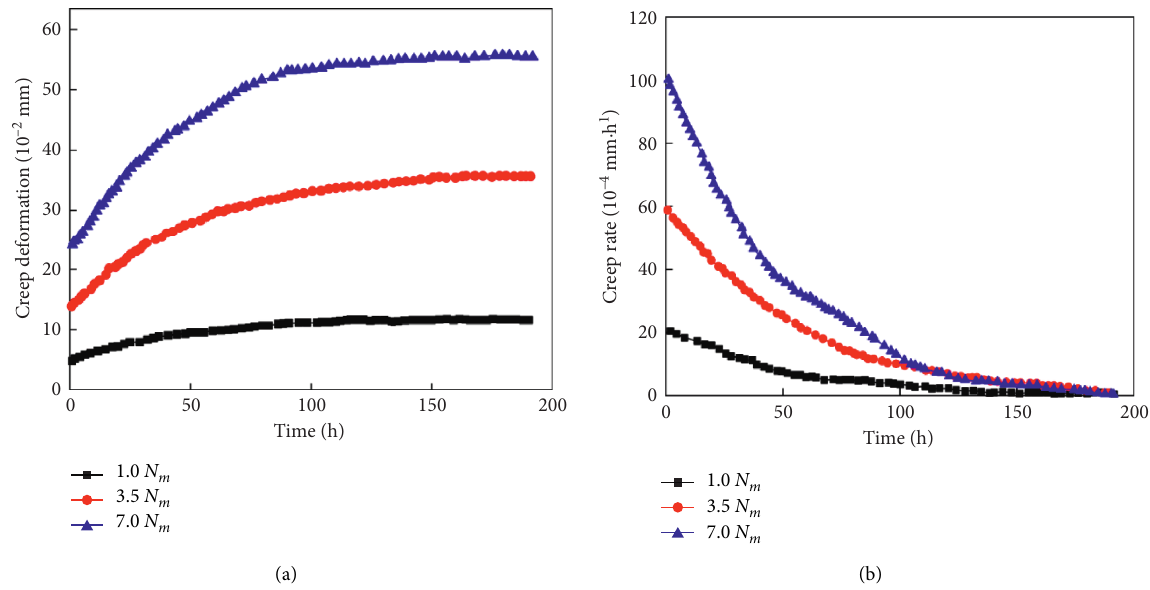
Figure 16: (a) Deformation and (b) rate of point WCJ6 measured during creep testing.